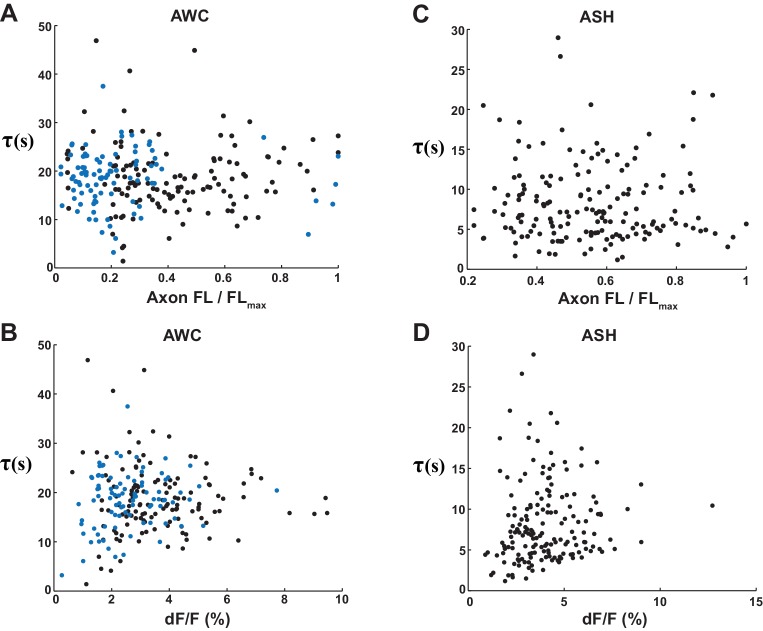
VGLUT-pH decay time constants are not correlated with expression level or response magnitude.(A) Scatter plot of AWCON VGLUT-pH decay time constants versus baseline axon fluorescence intensity. Two different AWCON VGLUT-pH transgenic lines with different expression levels are represented by the black and blue points. Axon intensities were normalized to the brightest axon detected in the line (FLMAX). Time constants are from single exponential fits, as in Figure 6. Correlation coefficient = 0.01, p=0.89, not significant. (B) AWCON decay time constants plotted against the magnitude of basal release, dF/F0 prior to stimulus onset; F0 is fluorescence level prior to stimulus removal. Correlation coefficient = 0.024, p=0.73, not significant. (C) Scatter plots of ASH VGLUT-pH decay time constants versus baseline axon fluorescence intensity. Correlation coefficient = −0.029, p=0.72, not significant. (D) ASH decay time constants after stimulus removal, compared to peak dF/F during stimulus. Correlation coefficient = 0.058, p=0.46, not significant. AWCONn = 218 (76 animals, 2–3 trials each). ASH n = 168 (56 animals, 2–3 trials each).